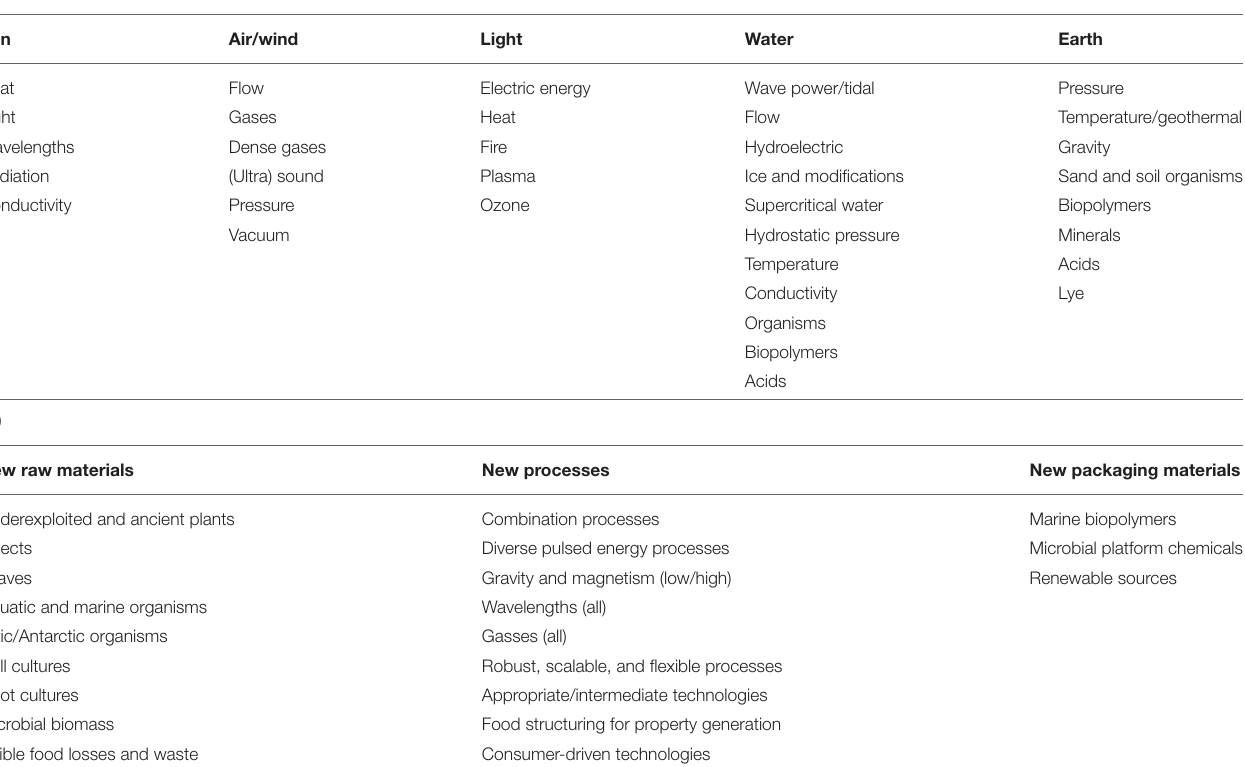
TABLE 1 | Existing natural elements used (A) and potential sources for (B) food processing.